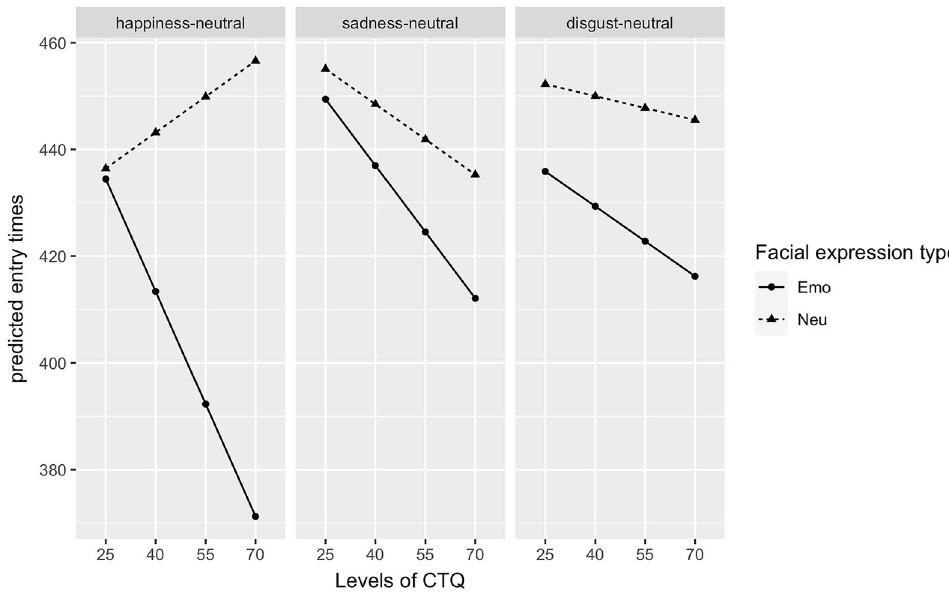
Figure 5. Predicted entry times on emotional and neutral facial expressions as a function of facial expression pairs and different levels of CTQ.